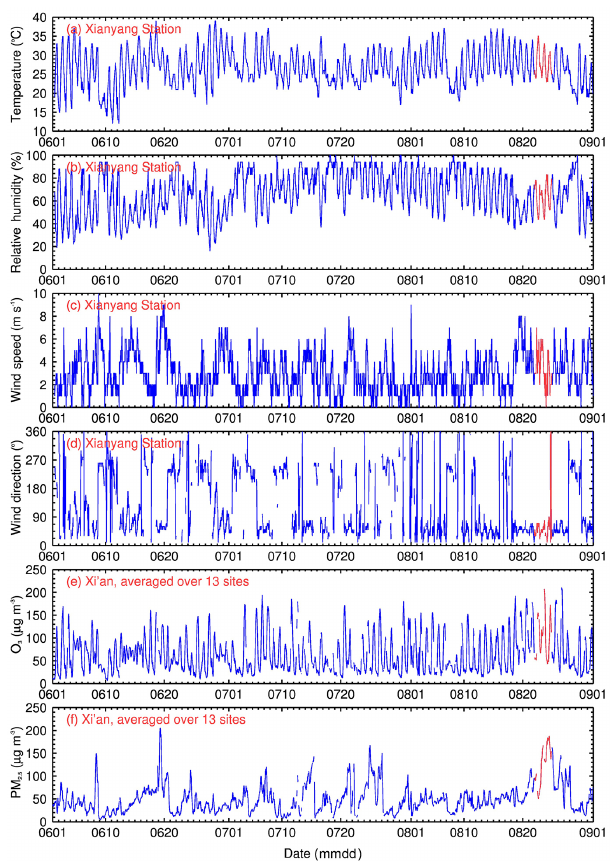
Figure 3. Temporal variations of the observed surface (a) temper- ature, (b) relative humidity, (c) wind speed, and (d) wind direction at Xianyang Meteorological Station and near-surface (e) O 3 and (f) PM 2 . 5 concentrations averaged over 13 sites in Xi’an during summer of 2013. Red curves depict the simulation period (22–24 August) in this study.